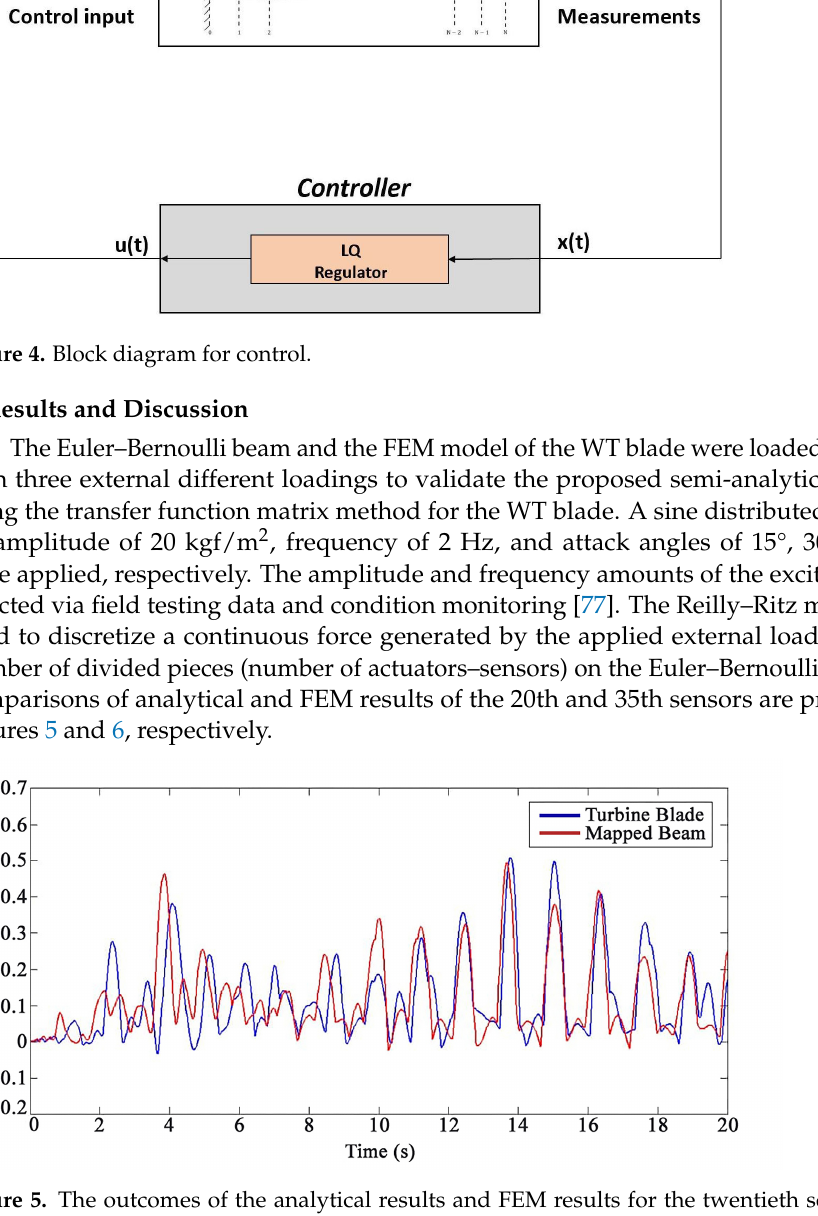
Figure 5. The outcomes of the analytical results and FEM results for the twentieth sensor under loading number 1 (15 degrees attack